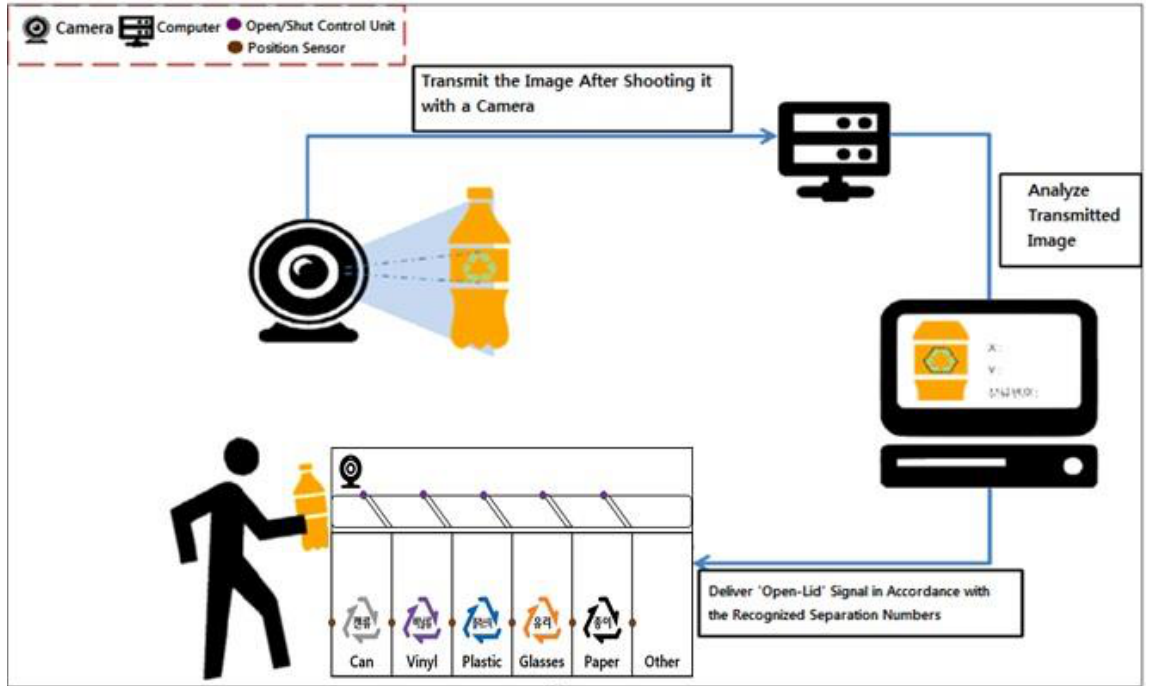
Figure 6. Design model processing process mechanism (Image Processing System + Spectroscope).